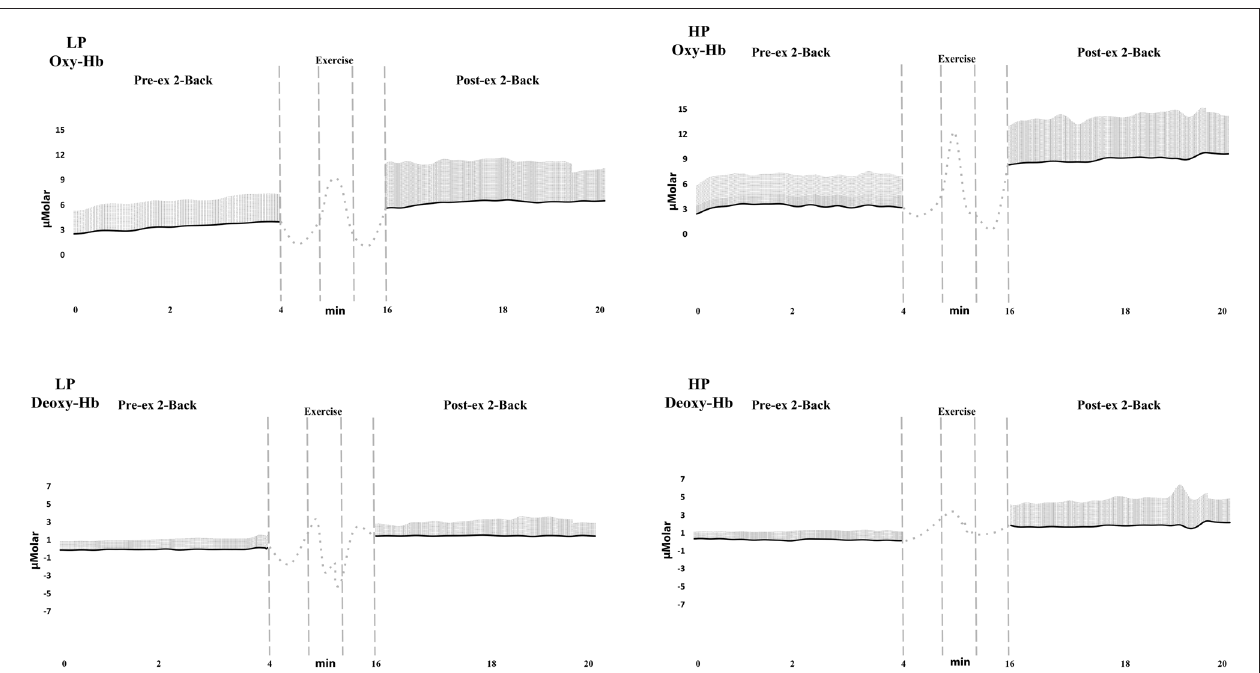
FIGURE 4 | The demonstration of oxy- and deoxy-Hb levels in central PFC area during pre- and post-exercise 2-Back tests for group averages. Standard deviations are also marked in line with average as vertical lines (Note that only positive deflection is displayed for the sake of simplicity). The four panels are divided into performers (low and high performance, left and right consequently) and oxy- and deoxy-Hb (upper and lower consequently). Left panel indicated oxy-Hb and right panel deoxy-Hb results. Vertical scale denotes the strength of fNIRS signal in µ Molar units, which is normalized to baseline. Horizontal scale denotes the time scale in minutes Vertical dashed lines denote pre-, during and post- exercise onsets and durations. The dotted lines represent the periods of warm-up and cool-down.